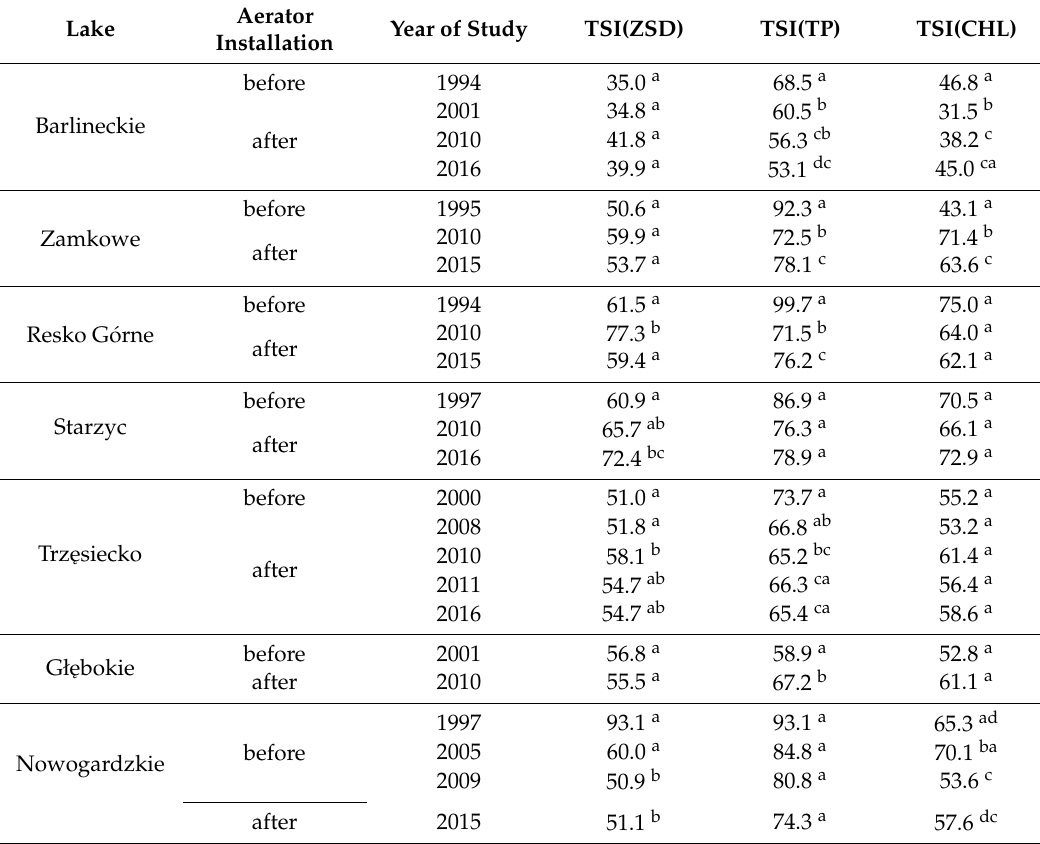
Table 3. Mean values of Carlson’s Trophic State Indices: TSI(SD), TSI(TP), TSI(CHL) of the tested lakes, calculated for the individual years of the research. Different letters (a, b, c....) indicate significant differences between means TSI for the entire study period ( α =